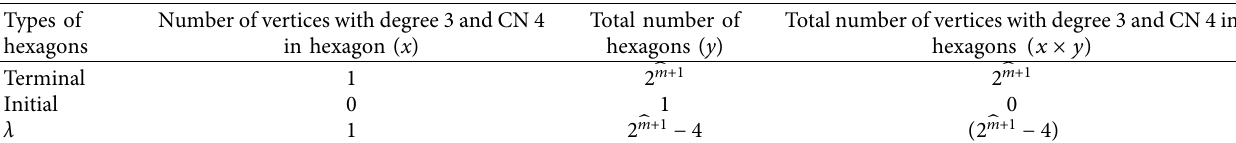
Table 6: Total number of vertices with degree 3 and CN 4 in ζ